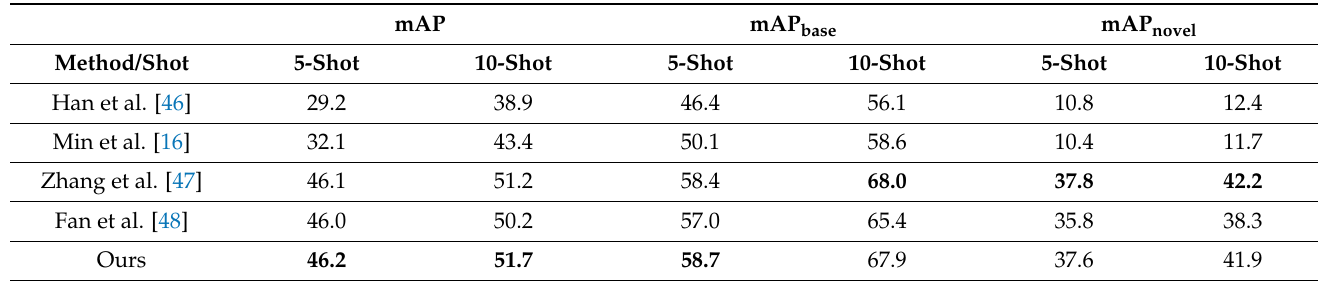
Table 4. Comparison of performance with other detectors under 10 shots.